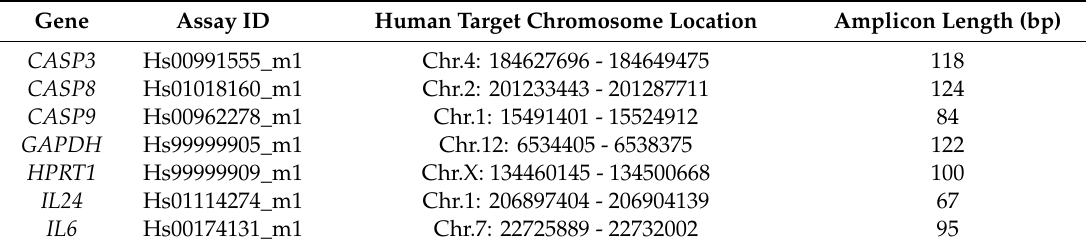
Table 2. List of selected TaqMan ® primer-sets (Applied Biosystems) utilized in this study and their respective RT-PCR assay IDs with target chromosome